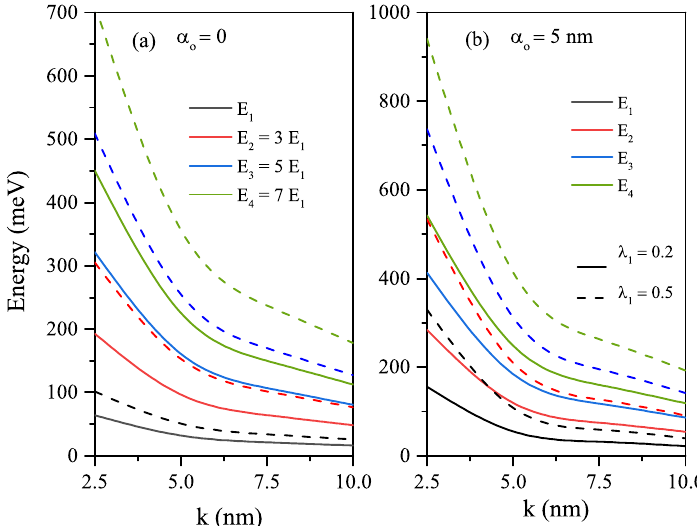
Figure 2. In the absence and presence of the ILF, the variations of the first four energy levels of the HO potential versus the width k -parameter for different λ 1 values: α 0 = 0 ( a ) and α 0 = 5 nm ( b ),